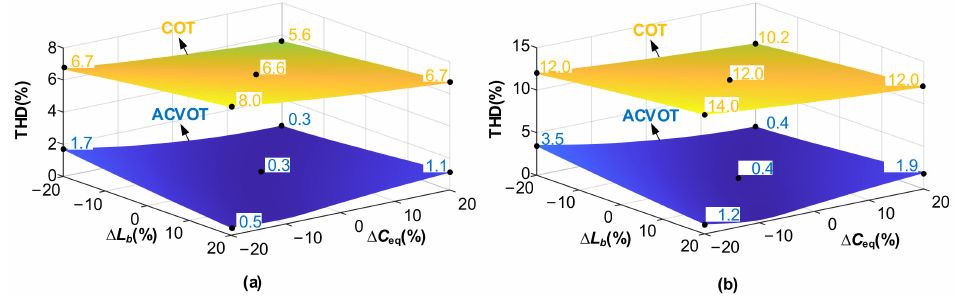
Figure 10. The THD surfaces with L b and C eq deviations: ( a ) 110 Vac; ( b ) 220 Vac.